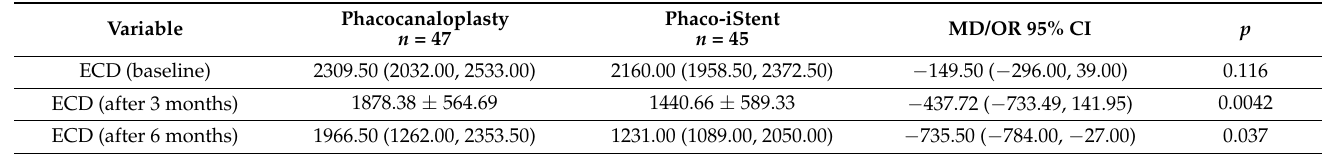
Table 3. Comparison of ECD according to type of surgery: baseline vs. further measurements.